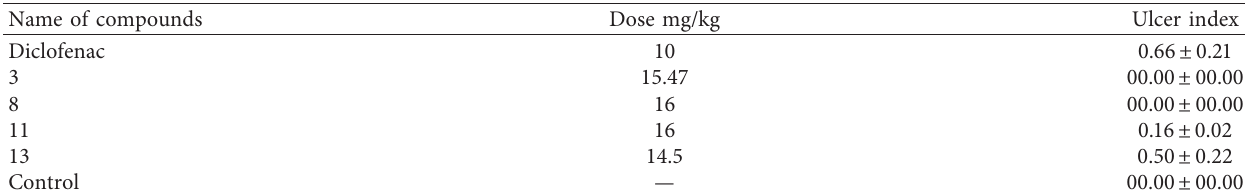
Table 4: Ulcer study of active compounds.